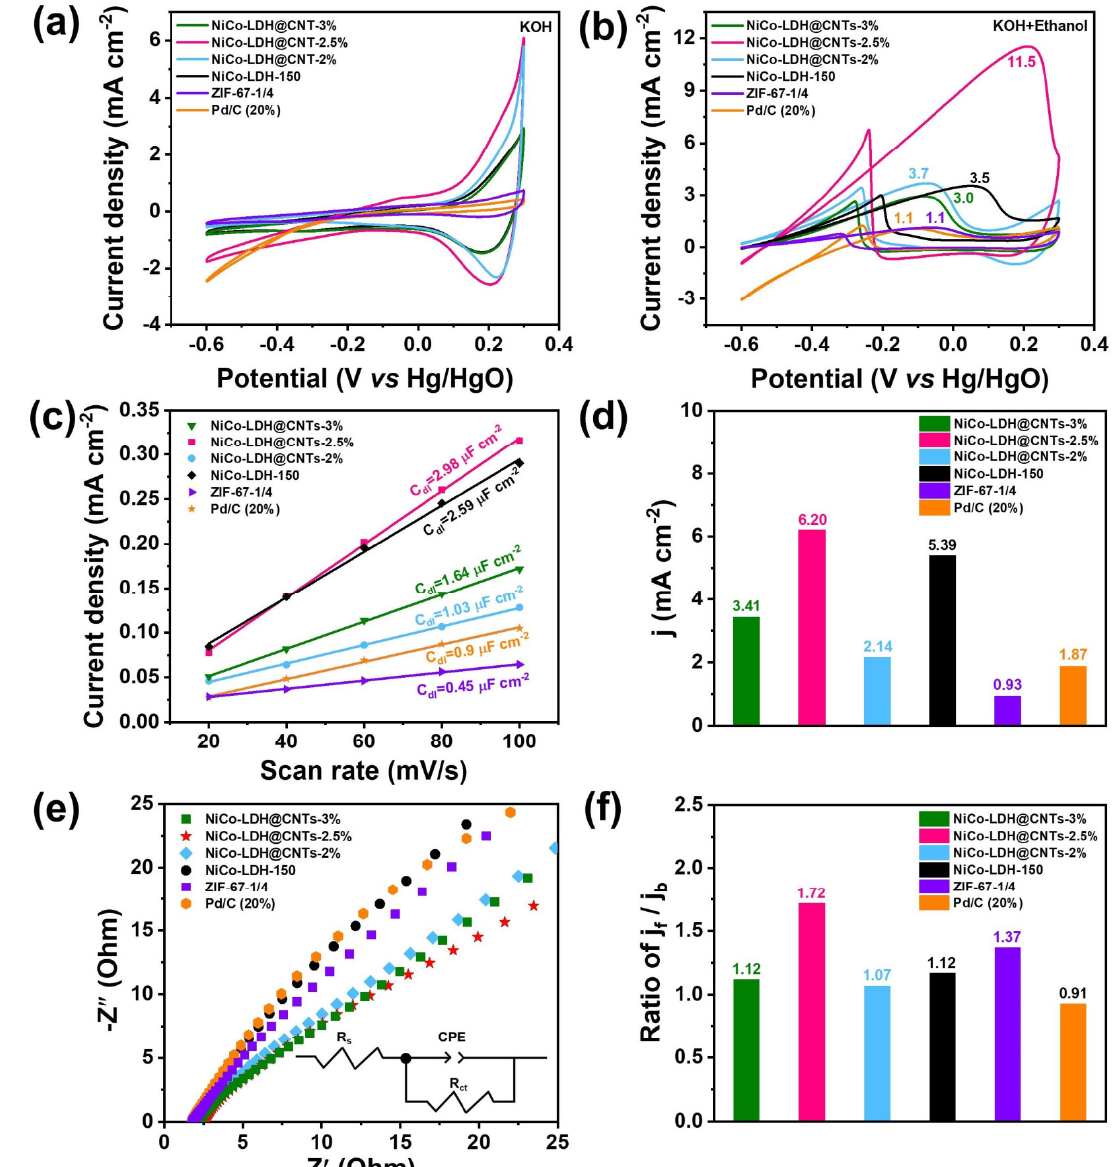
Figure 5. The CV curves of Pd/C (20%), ZIF-67-1/4, NiCo-LDH-150, and NiCo-LDH@CNTs- z % ( z = 2, 2.5, and 3) in ( a ) 1.0 M KOH and ( b ) 1.0 M KOH and 1.0 M ethanol solution saturated with nitrogen at 20, 40, 60, 80, and 100 mV s -1 sweep rate. ( c ) C dl , ( d ) ECSA, ( e ) EIS spectra, and ( f ) j f /j b of Pd/C (20%), ZIF-67-1/4, NiCo-LDH-150, and NiCo-LDH@CNTs- z % ( z = 2, 2.5, and 3), respectively.